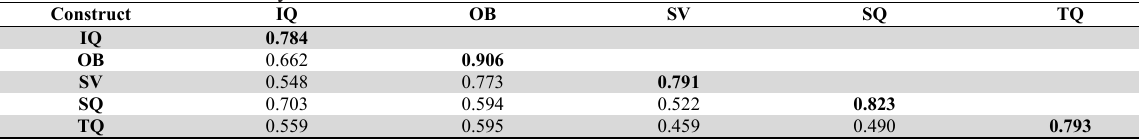
Results of discriminant validity- Fornell and Larcker method Construct